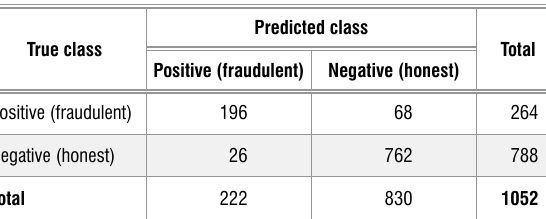
Predicted classes for the first iteration of the support vector